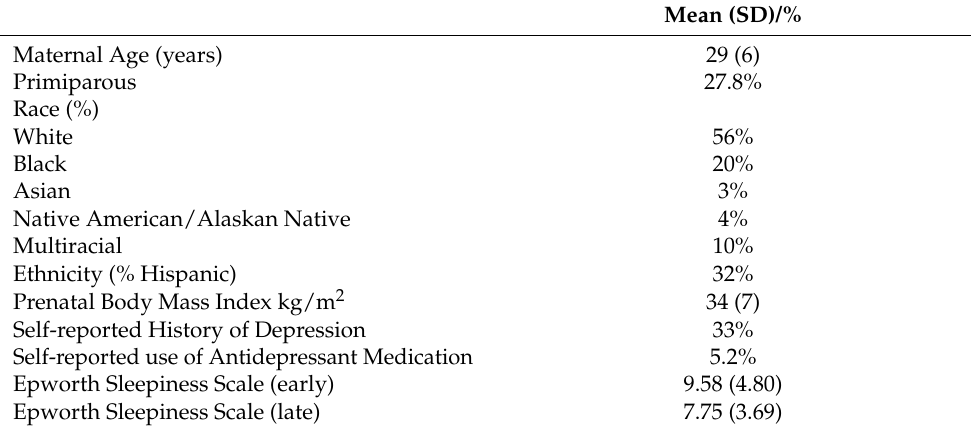
Table 1. Demographic